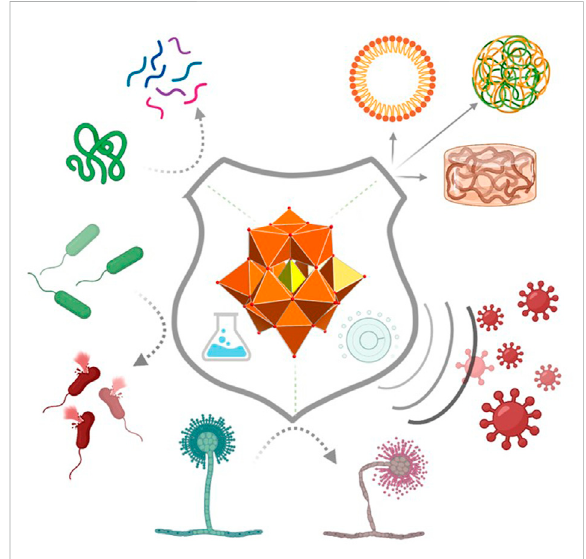
POMs are described with anticancer, antiviral, and antimicrobial activities as well as other biological or biomedical applications such as arti fi cial protease activity (top-left) and self- assembly with biomacromolecules to make micelles, gels & other superstructures